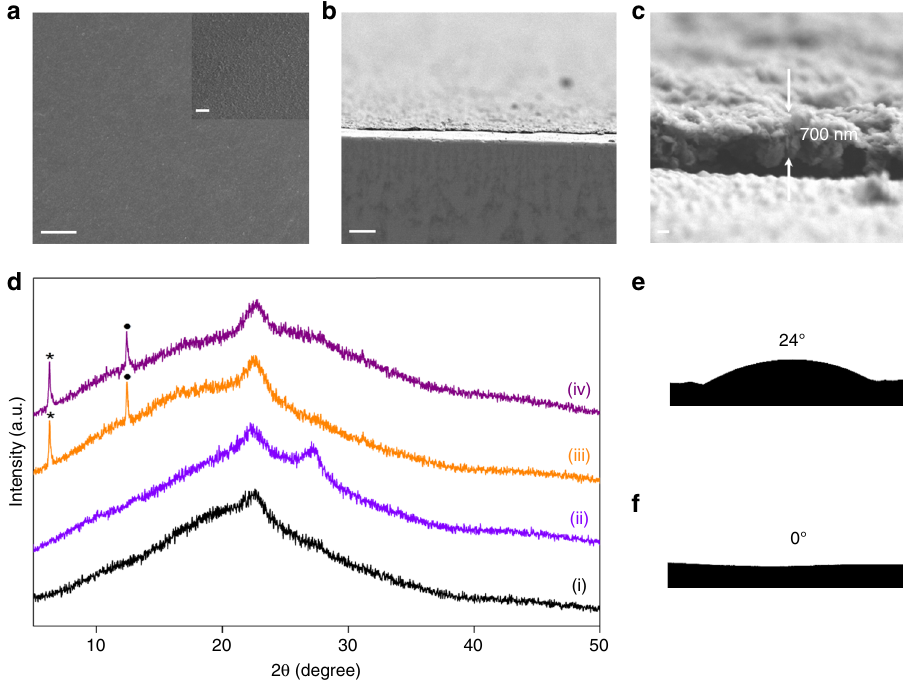
Fig. 2 Characterizations of GCN-SA membrane. a – c Top-view ( a ) and cross-sectional ( b , c ) SEM images of GCN-SA membrane. d X-ray diffraction patterns of (i) blank MCE substrate; (ii) dried GCN membrane on MCE; (iii) dried GCN-SA membrane on MCE; (iv) dried GCN-SA membrane on MCE after immersing in water for 3 days. Peaks marked as black stars and balls denote the diffraction peaks (001n) and (002n), respectively, n denotes the new phase. e , f Digital photos of water drop ( e ) and cyclohexane drop ( f ) on CN-SA membrane. Scale bars for a , b : 10 μ m, inset of a : 1 μ m and c : 200